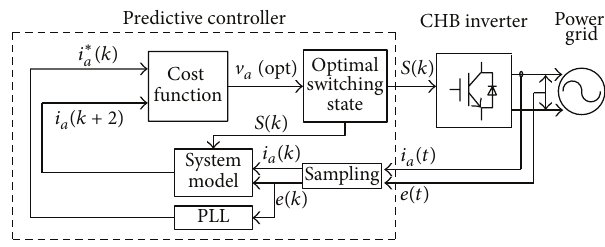
Figure 4: Block diagram of the two-step FS-MPC